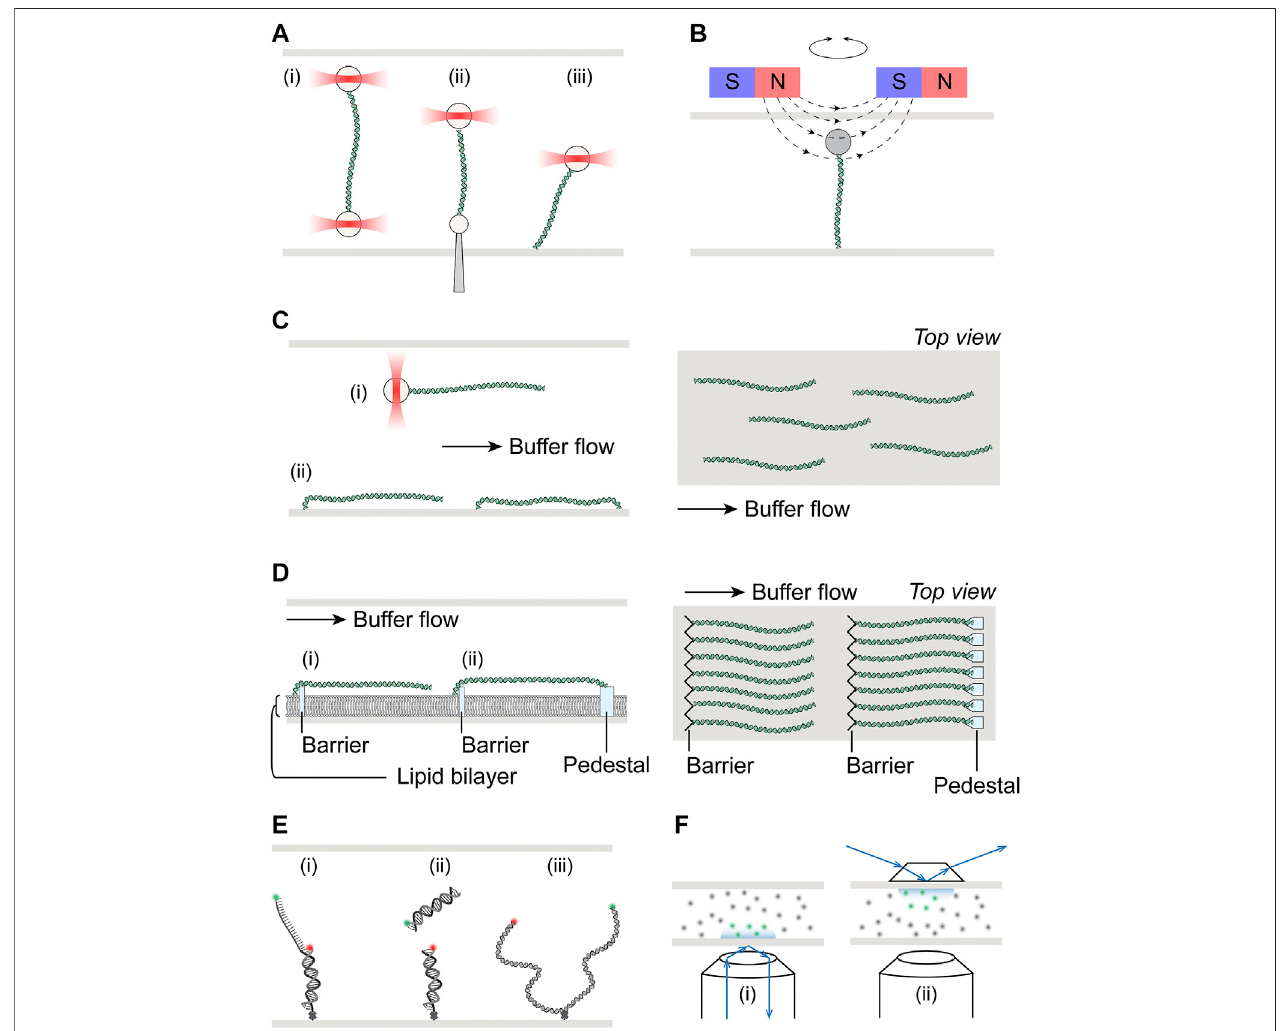
FIGURE1| Schematicsofsingle-moleculesetups. (A) Schematicillustrationofopticaltweezers,whereasingleDNAmoleculeistetheredatoneendtoanoptically trappedbead,andtheotherendto (i) anotherbeadheldinasecondopticaltrap, (ii) amicro-pipette fi xedtothe fl owcell,or (iii) thesurfaceofthe fl owcell. (B) Schematic illustration of magnetic tweezers, where a single DNA molecule is held between a magnetic bead and the fl ow cell surface. Torsional stress can be applied by rotation of the external magnets. (C) Left: Hydrodynamic fl ow extension of DNA molecules attached to either (i) an optically trapped bead or (ii) the fl ow cell surface. DNA moleculesmaybetetheredtothesurfaceatbothendsifdesired. Right: Topviewof fl owextendedandsurfacetetheredDNAina fl owcell,illustratingtherandomspatial distribution of these molecules. (D) Left: Schematic of DNA curtains where molecules tethered at one end to the lipid bilayer are aligned at the diffusion barrier. Single- tethered DNA may be extended by buffer fl ow (i) . Alternatively, DNA maybe double-tethered at the pedestal (ii) . Right: Top view of single- or double-tethered DNA curtains, where molecules are aligned in uniformity. (E) Schematic illustration of smFRET, where the energy transfer may be either intramolecular (i) and (iii) or intermolecular (ii) . DNA molecules are immobilized on the fl ow cell surface via biotin-streptavidin linkage with biotin placed at the ends of short substrates (i) and (ii) , or internally for ∼ kbp length substrates (iii) . (F) Schematic illustrate of total internal re fl ection fl uorescence microscopy (TIRFM), achieved either through objective (i) or through prism (ii) . Green and gray dots represent excited inside and dark fl uorophores outside the evanescence fi eld, respectively.